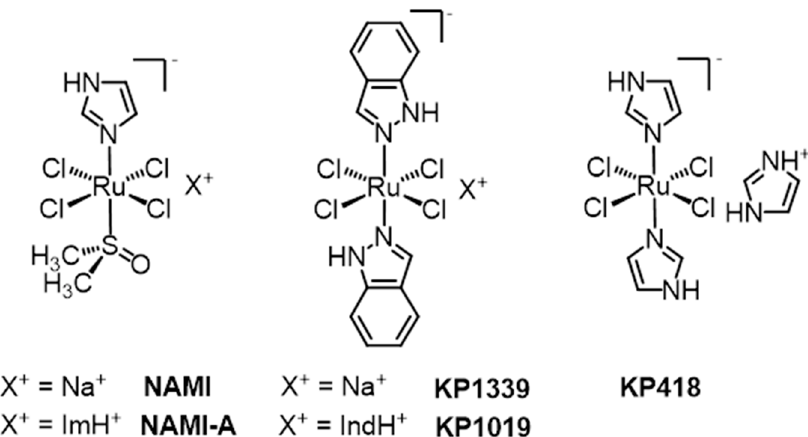
Figure 1. Schematic structures of NAMI-A ((ImH)[ trans -RuCl 4 (dmso-S)(Im)], Im = imidazole), KP1019/KP1339 (KP1019 = (IndH)[ trans -RuCl 4 (Ind) 2 ], Ind = indazole; KP1339 = Na[ trans -RuCl 4 (Ind) 2 ]), and KP418 (imidazolium trans -bis-imidazoletetrachlororuthenate(III), (ImH)[ trans -RuCl 4 (Im) 2 ]). KP1019 is sometimes also called FFC14, or FFC14a, or FFC14A. The sodium salt of KP1019, besides KP1339, is also called KP-1339, or NKP1339, or—more recently—IT-139. Originally, the imidazole complex KP418 was called ICR.